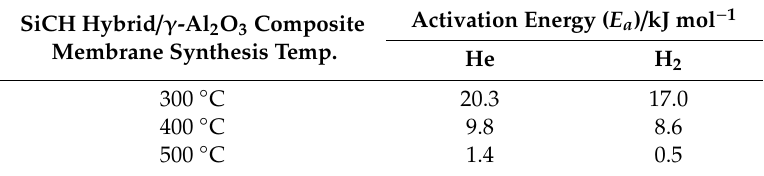
Table 1. Activation energies for He and H 2 permeations through the supported mesoporous γ -Al 2 O 3 membrane after modification with AHPCS and subsequent heat treatment at 300–500 °C.